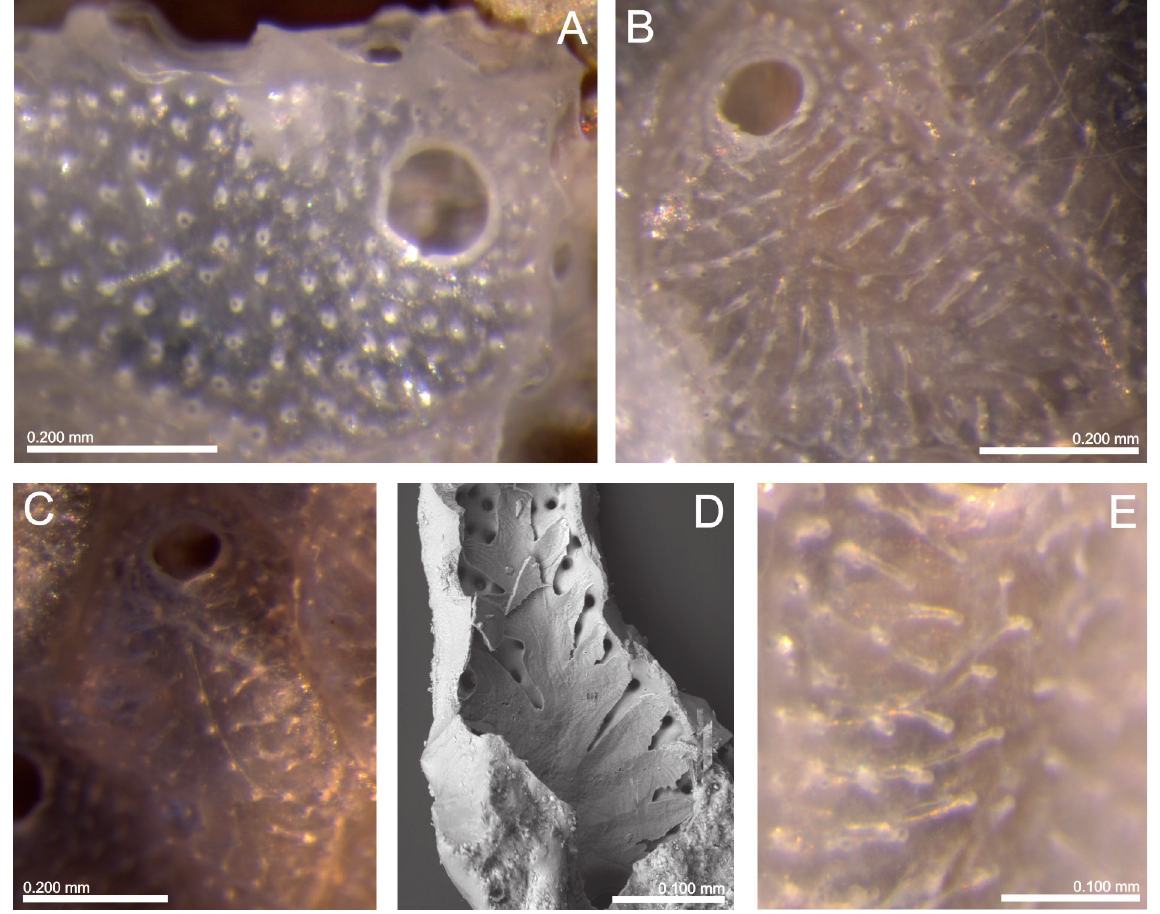
Fig. 3. Pulpeirina amoena (Jullien & Calvet, 1903) comb. nov. (MOM INV-22580). A . Simple pores in a young, marginal autozooid. B . Tubular pores arranged radially. C . An autozooid with radially arranged tubular pores and a medial horizontal tubule. D . Inner view of an autozooid showing the tubular pseudopores and horizontal tubules. E . Detail showing tubular pores joining the horizontal